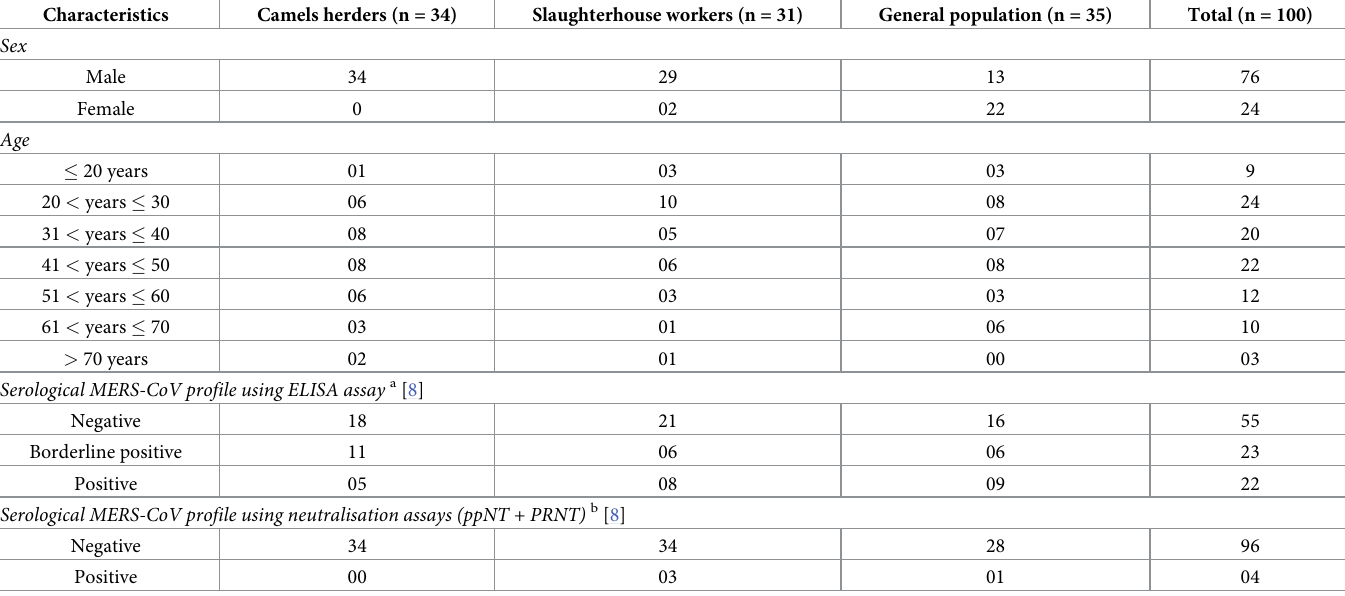
Table 2. Middle East respiratory syndrome coronavirus (MERS-CoV) study population demographics, dromedary exposure and serological profile by study group.